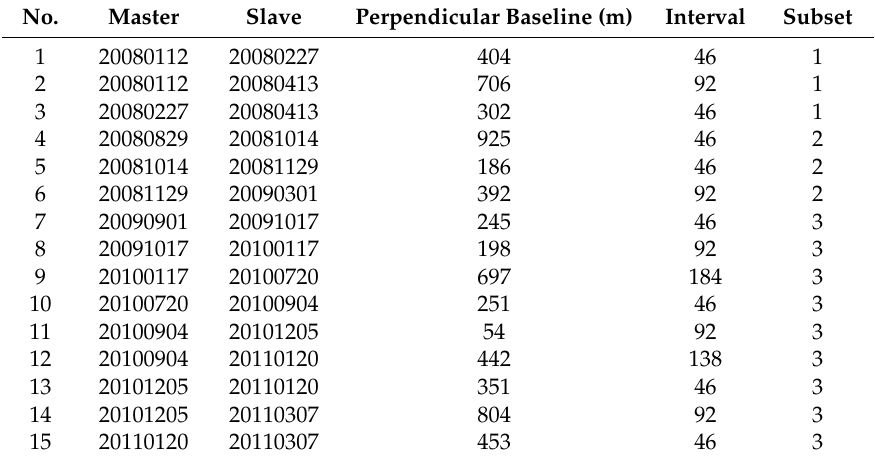
Table 1. The parameters of interferometric pairs for landslide deformation